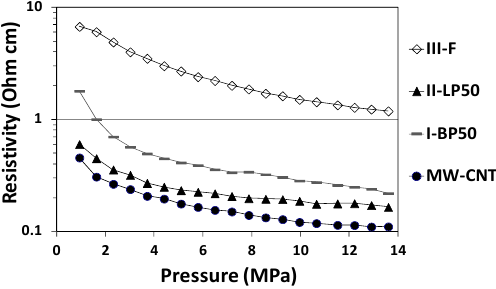
Figure 6. Resistivity (in logarithmic scale) of conductive MW ‐ CNTs at different pressures before (MW ‐ CNTs) and after PFPE ‐ functionalization with branched ( I ‐ BP50 ) and linear ( II ‐ LP50 ) peroxides and after fluorination with F 2 ( III ‐ F ).